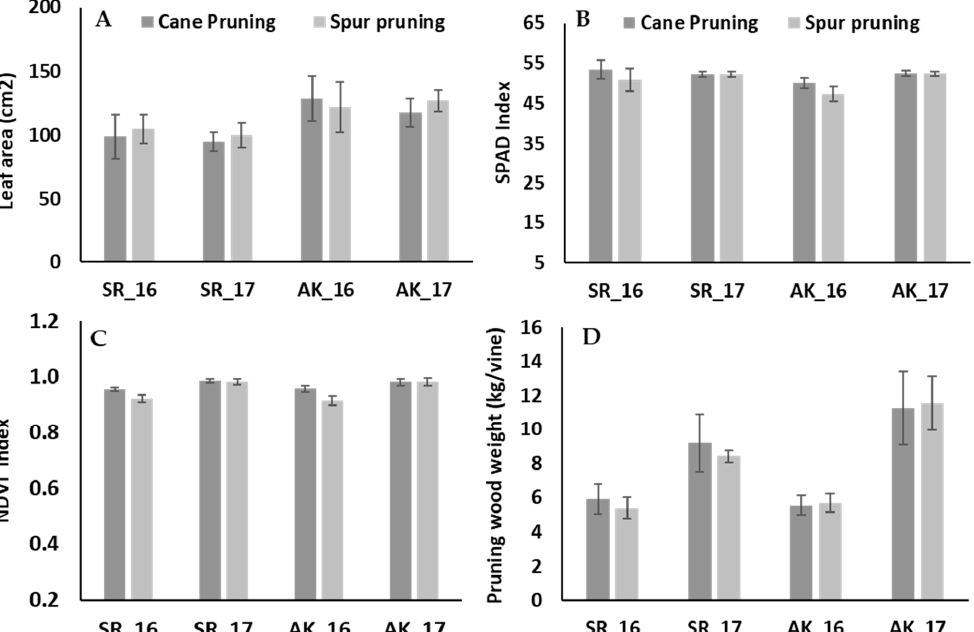
Figure 1. Effect of Head training, cane pruning and Quadrilateral cordon training, spur-pruning systems on Leaf area ( A ), SPAD index ( B ), NDVI index ( C ) and pruning weight ( D ) of Scarlet Royal (SR) and Autumn king (AK) table grapes during 2016 and 2017 seasons. ANOVA statistical analysis was used to measure the differences among treatments at a 0.05 significance level. Error bars represent the standard deviation.